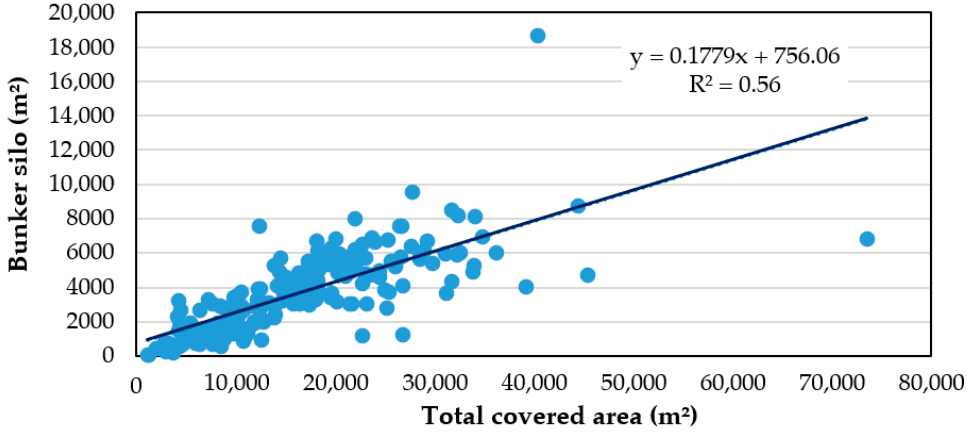
Figure 6. Correlation between storage areas and total covered area.